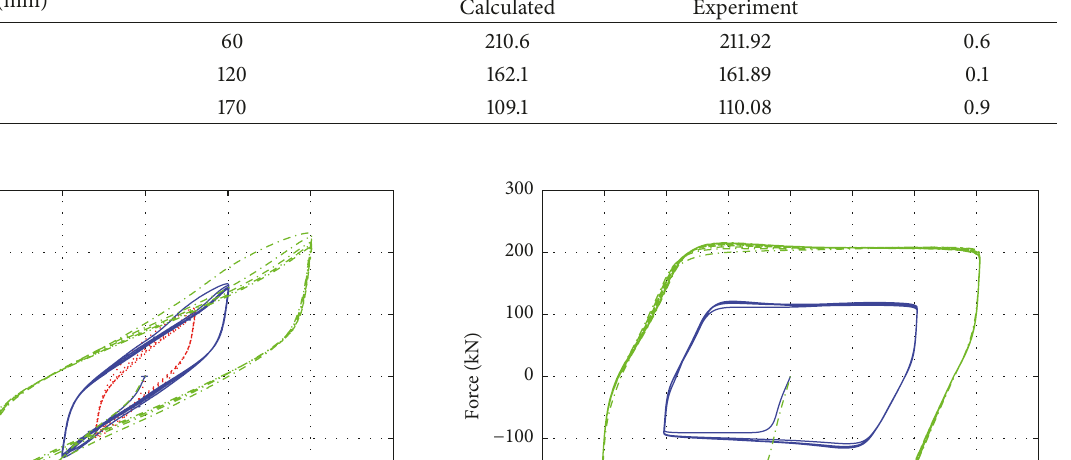
Table 2: Initial stiffness according to different pitches of bolts on the flange of the T-steel. Pitches of bolts on the flange of the T-steel (mm)